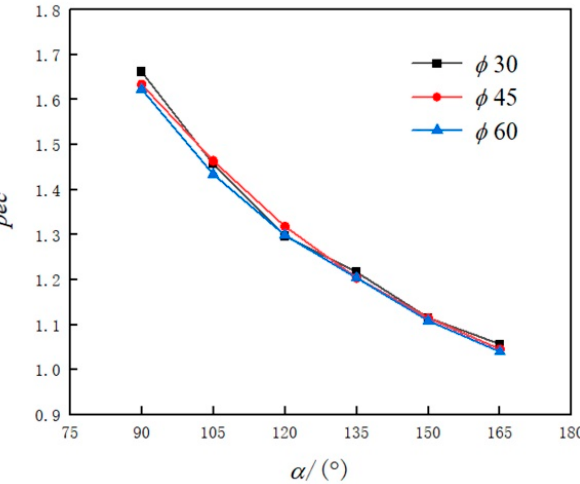
Figure 14. Comprehensive performance evaluation factor pec changing with the central angle α for straight pipes.